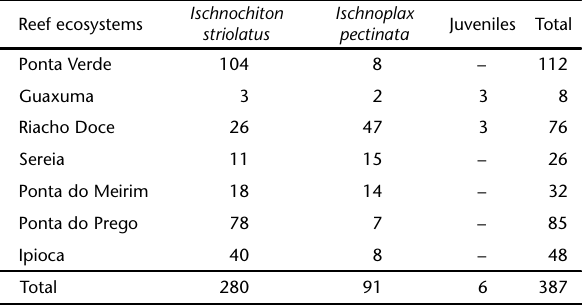
Table 1. Polyplacophora species distribution from reef ecosystems on the Maceió coast in Alagoas. Ischnochiton Ischnoplax Reef ecosystems Juveniles Total striolatus pectinata Ponta Verde